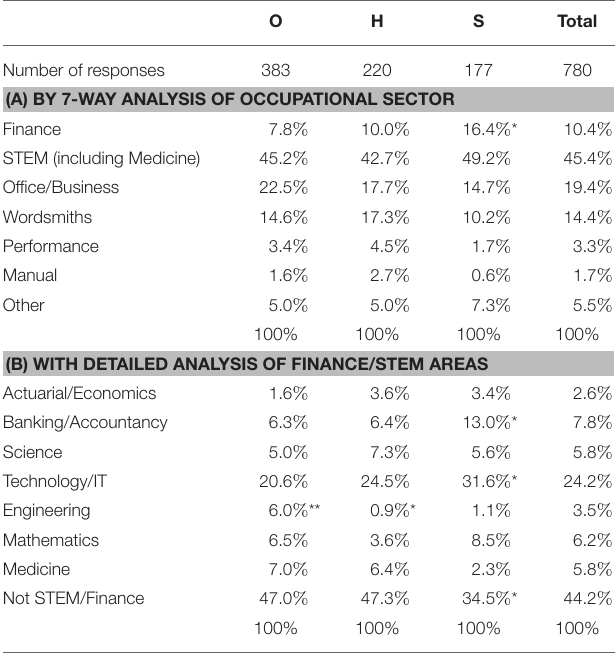
TABLE 5 | Percentage involvement in occupational categories, by expertise